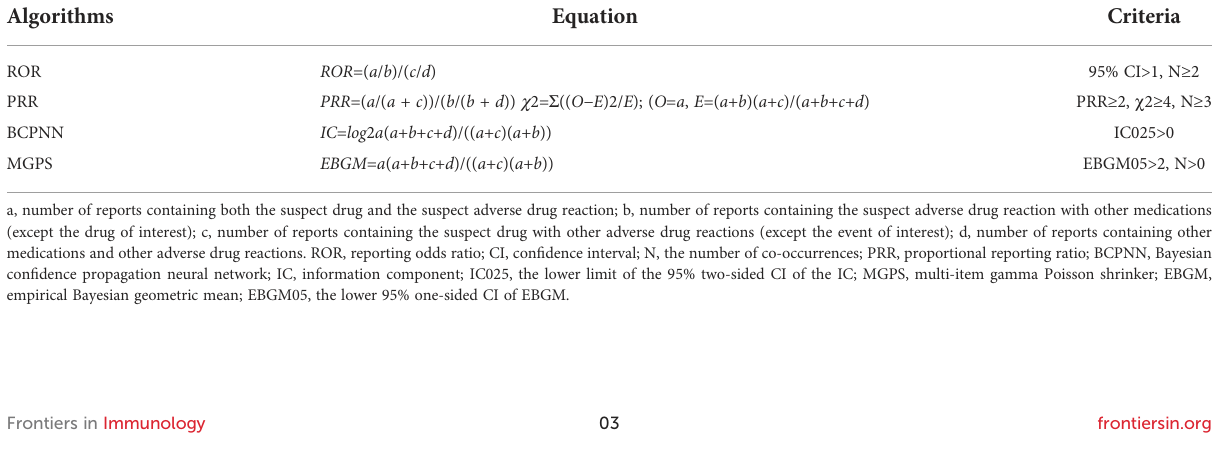
TABLE 1 Summary of major algorithms used for signal